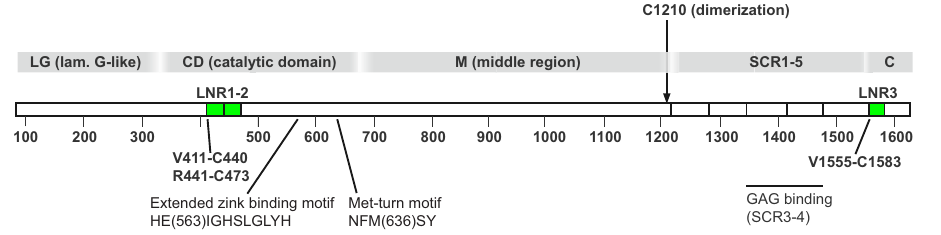
Fig. 1 | Modular structure of the 1546-residue PAPP-A (pappalysin-1) subunit. Approximate domain boundaries and the cysteine residue responsible for PAPP-A dimerizationareindicated.NotethattwoLin12-Notchrepeat(LNR)modules(LNR1- 2) are inserted into the catalyticdomain (CD), and a third (LNR3) ispresent aspart oftheCdomain.Nosequencesimilarityhasbeendetectedforthecentralregionof